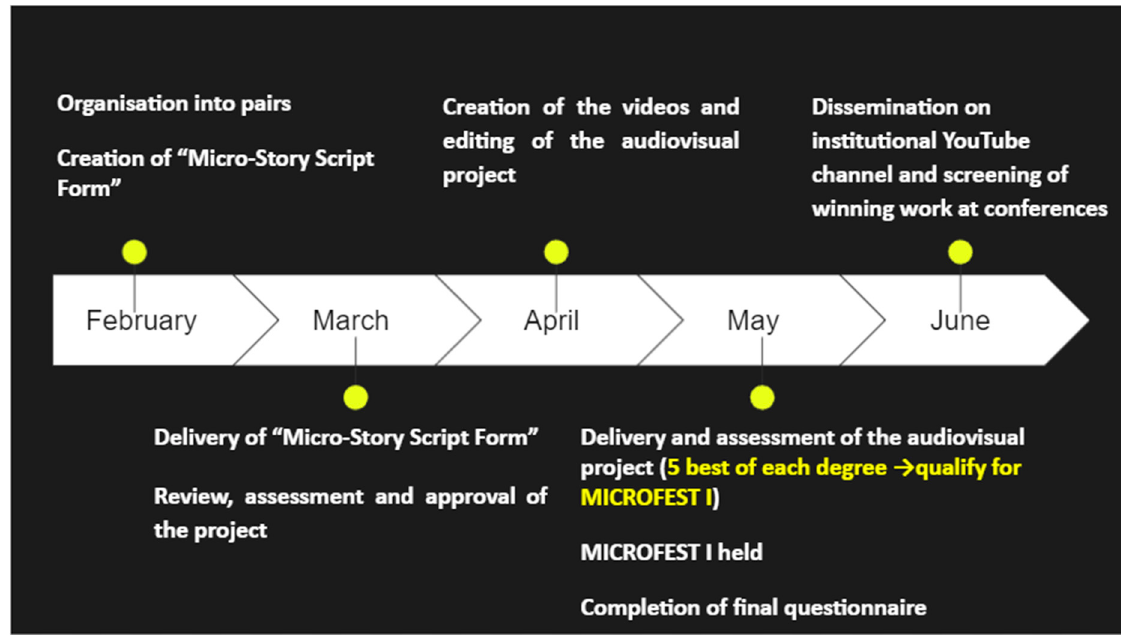
Figure 1. MICROFEST project timeline.